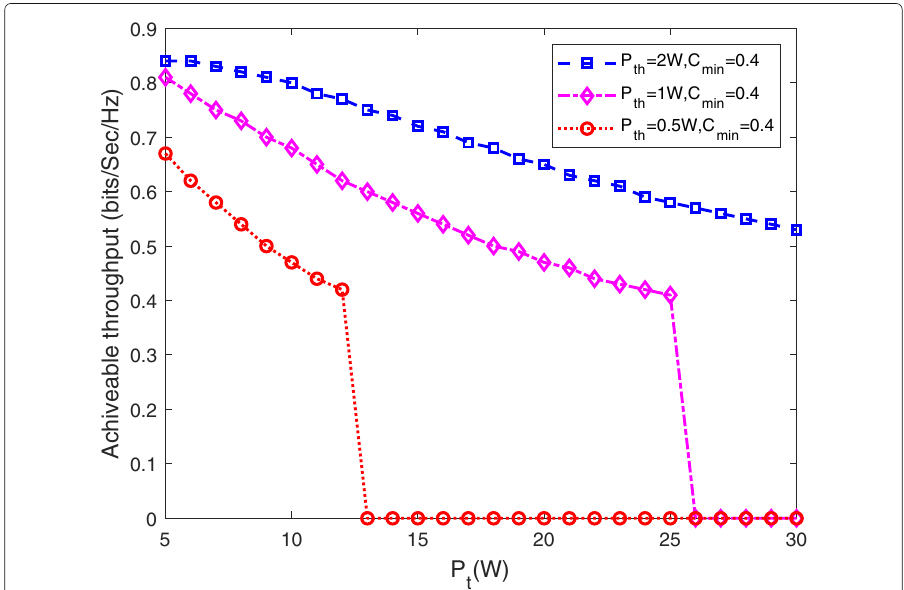
Fig. 4 Achievable throughput optimization performance versus P